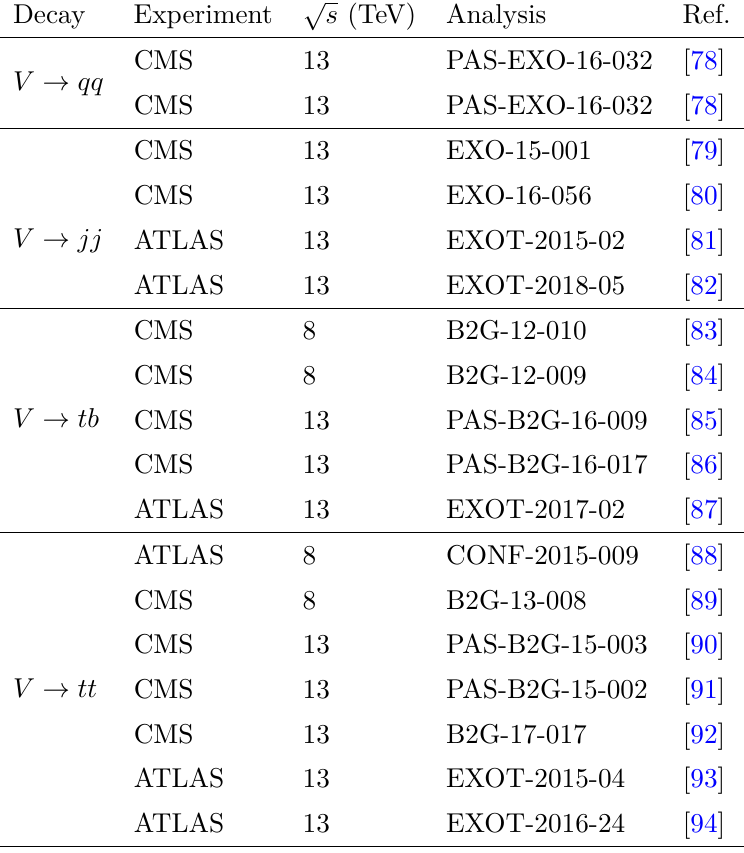
Table 8. Experimental analyses of hadronic decay channels of vector resonances we use to judge the fitness of our points. Here, j refers to a light quark or b jet, and q refers to a light quark